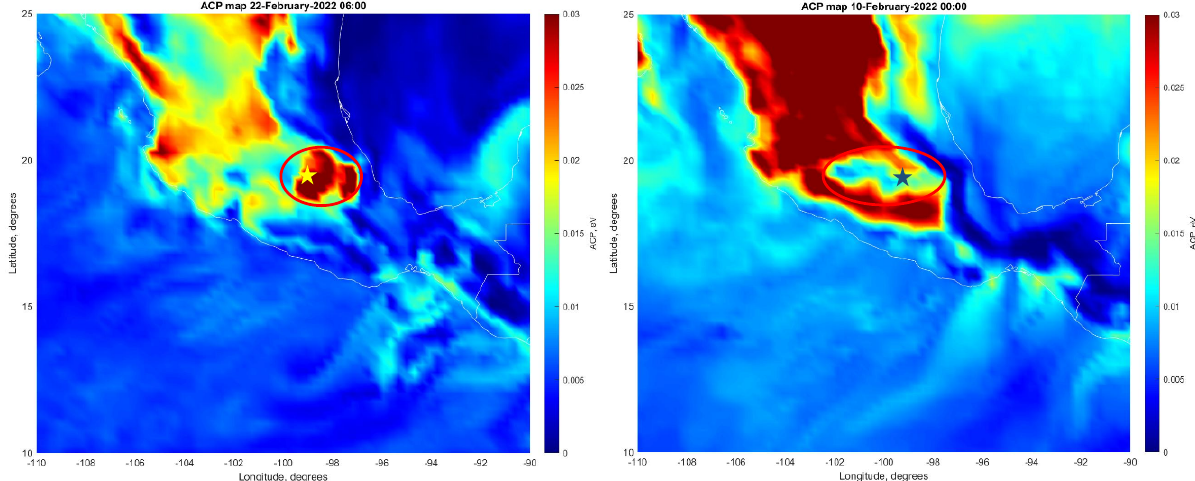
Figure 10. The typical urban heat island profile (credit to NOAA). http://www.crh.noaa.gov/images/ lsx/recent_event/urban.gif (accessed on 10 October 2022).